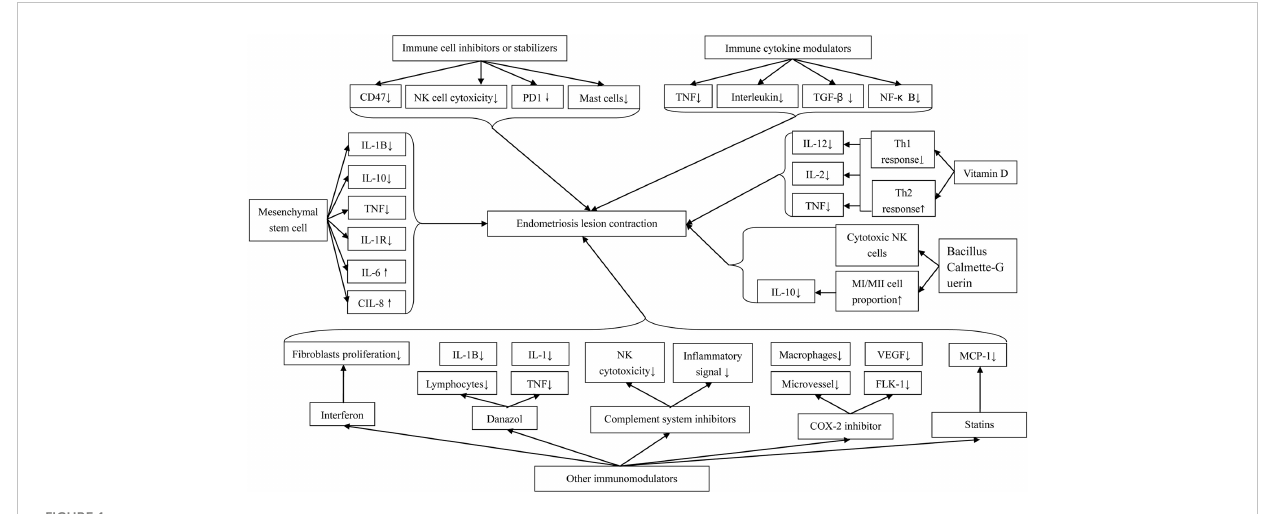
FIGURE 1 Immunotherapeutic Methods for